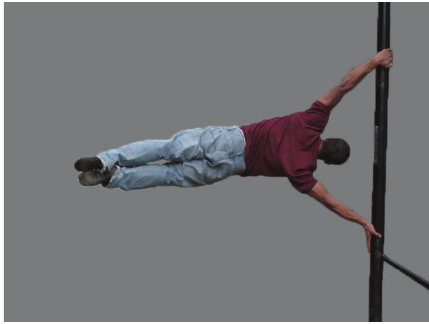
Figure 1: An example of the flagpole exercise.